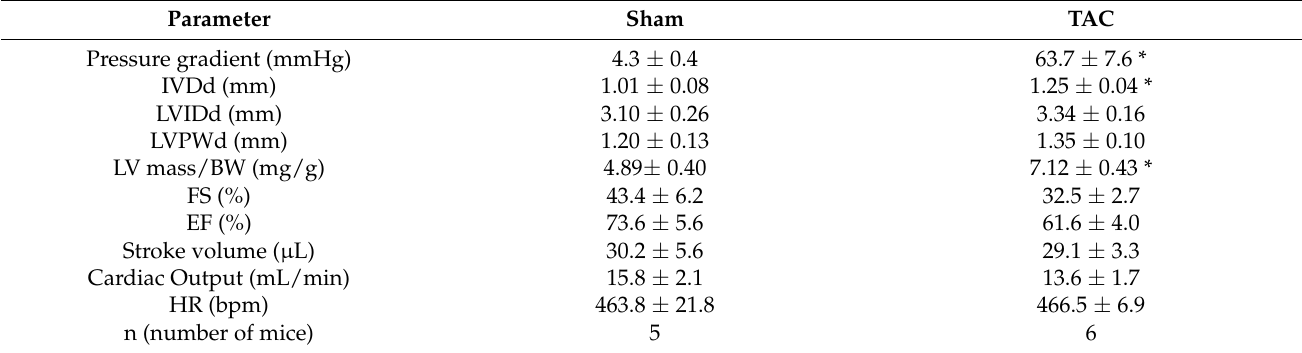
Table 2. Echocardiographic parameters measured in E1-CAAX mice 8 weeks after Sham or TAC surgery.